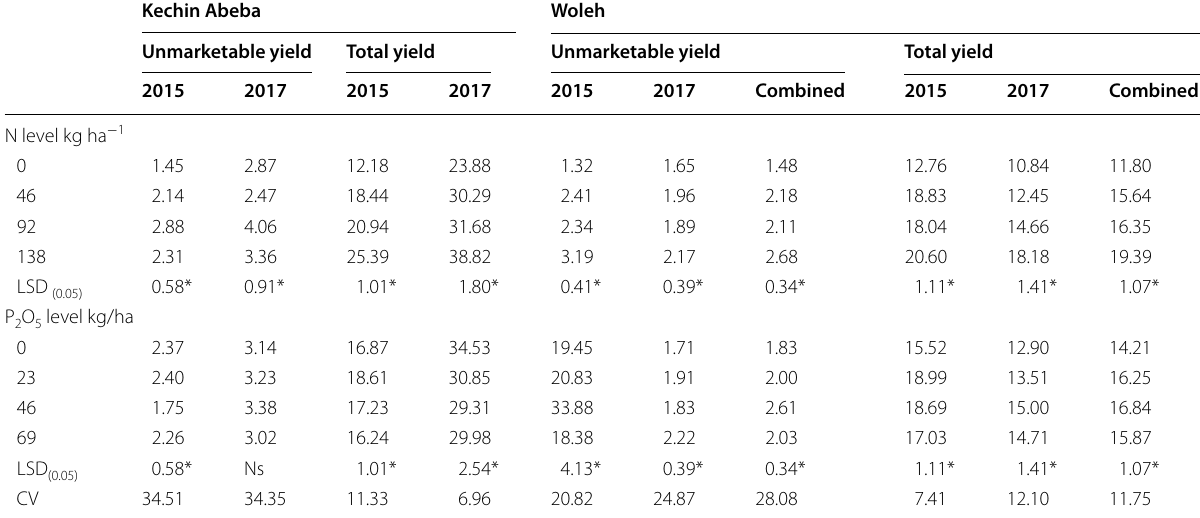
Table 8 Effect of nitrogen and phosphorus on unmarketable and total yield (t ha − 1 ) of potato at Woleh Kechin Abeba Woleh